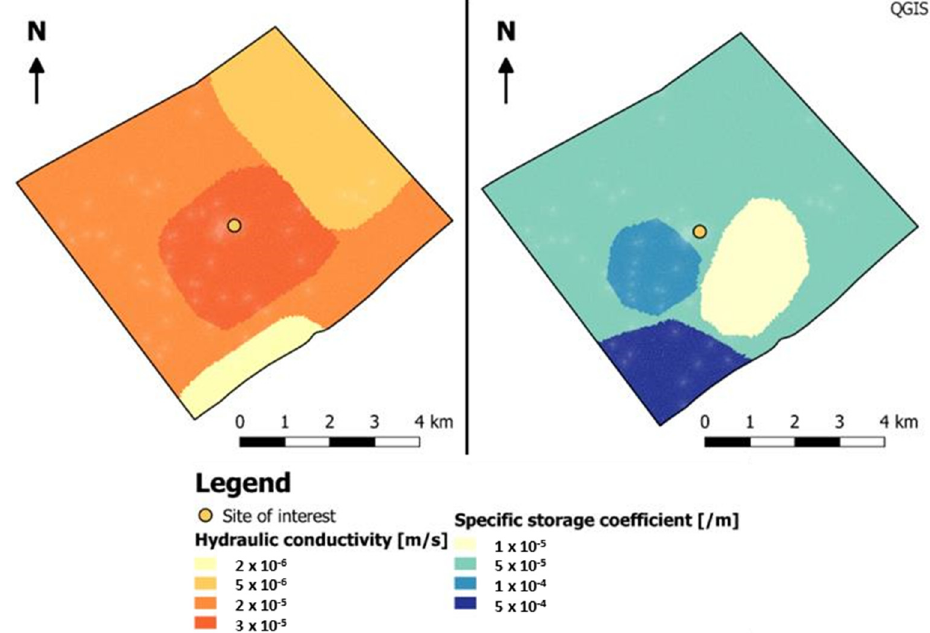
Figure 5. Distribution of hydraulic conductivity ( left ) and specific storage coefficient ( right ) values in the first five layers of the model.